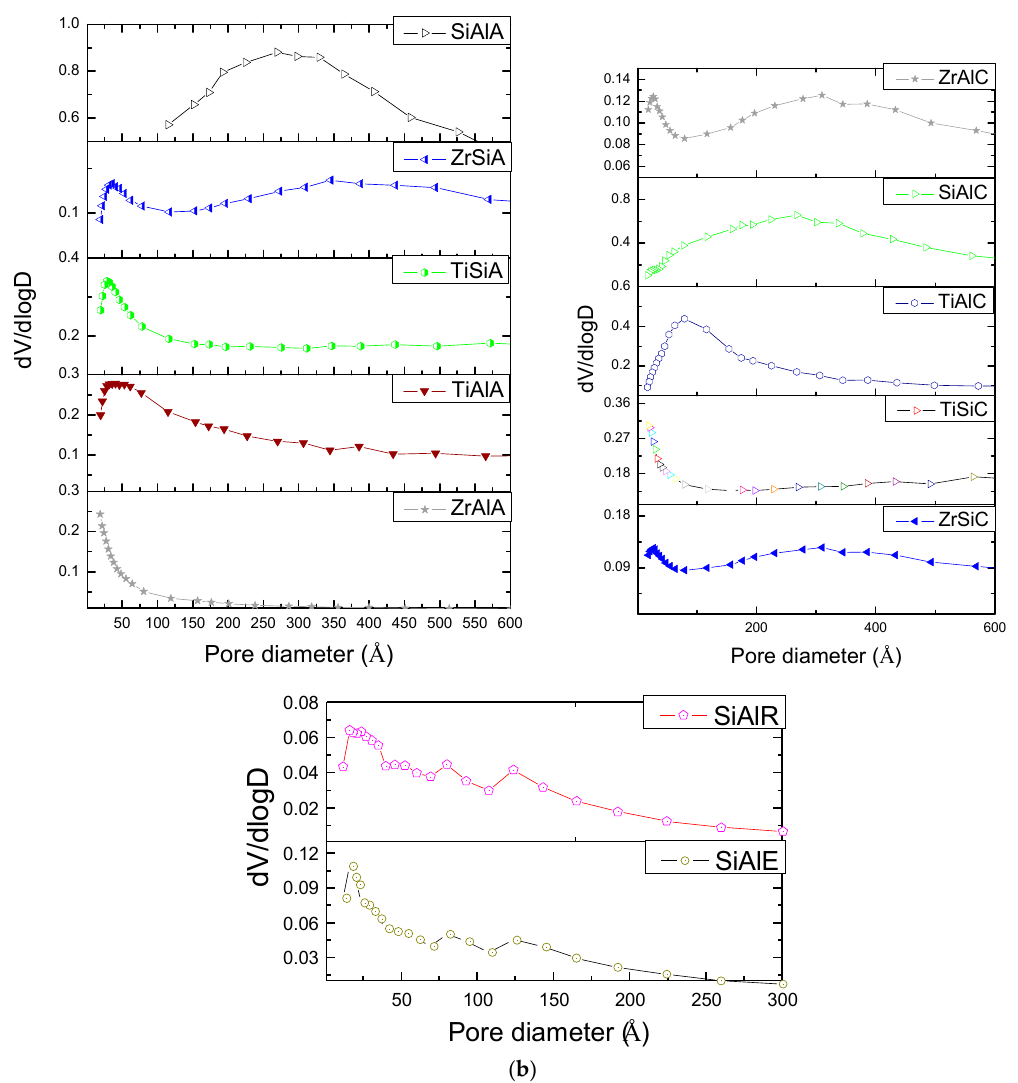
Figure 5. ( a ) Nitrogen adsorption ‐ desorption isotherms of the samples ( b ) and their corresponding pore size distribution plots.